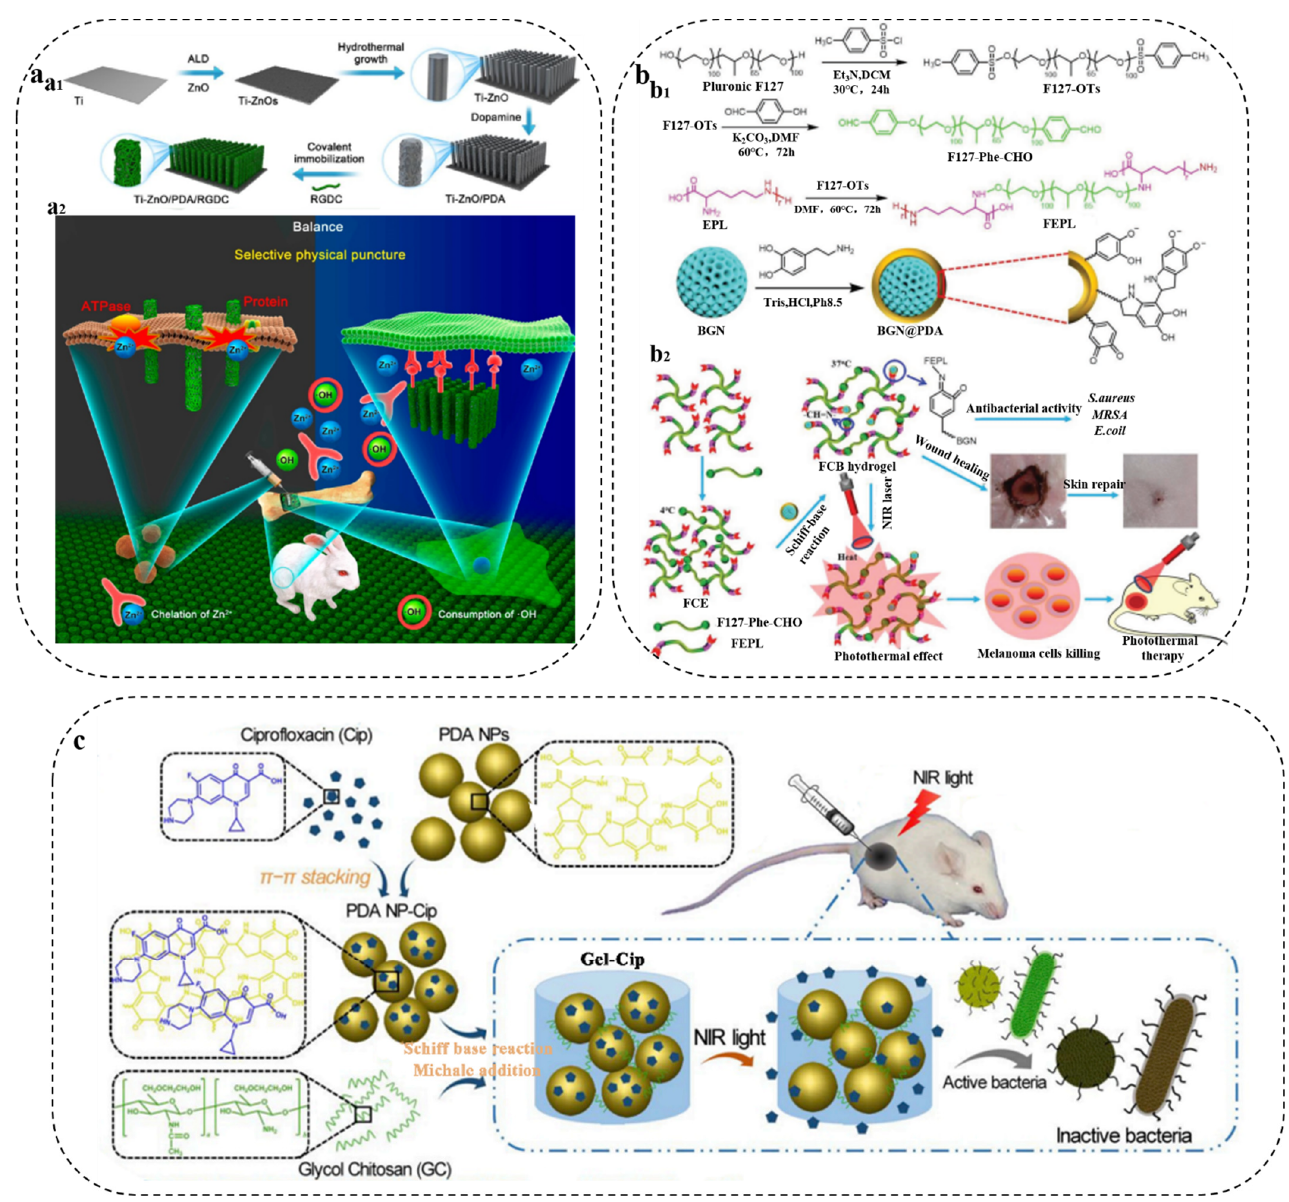
Figure 7. ( a ) Schematic illustration of the fabrication process of the hybrid ZnO/PDA/RGDC NR arrays on Ti ( a1 ) and balancing bacteria-osteoblast competition on Ti modified with ZnO/PDA/RGDC hybrid NR arrays in vivo ( a2 ). Reprinted with permission from [97] (copyright: American Chemical Society, 2017). ( b ) Schematic illustration of the preparation ( b1 ) and application ( b2 ) of the nanocomposite hydrogel in tumor therapy and wound healing. Reprinted with permission from [99] (copyright: Wiley-VCH, 2021). ( c ) Schematic illustration of the Gel-Cip synthetic route and antibacterial property of on-demand antibiotic release triggered by NIR light irradiation. Reprinted with permission from [102] (copyright: Elsevier, 2019).